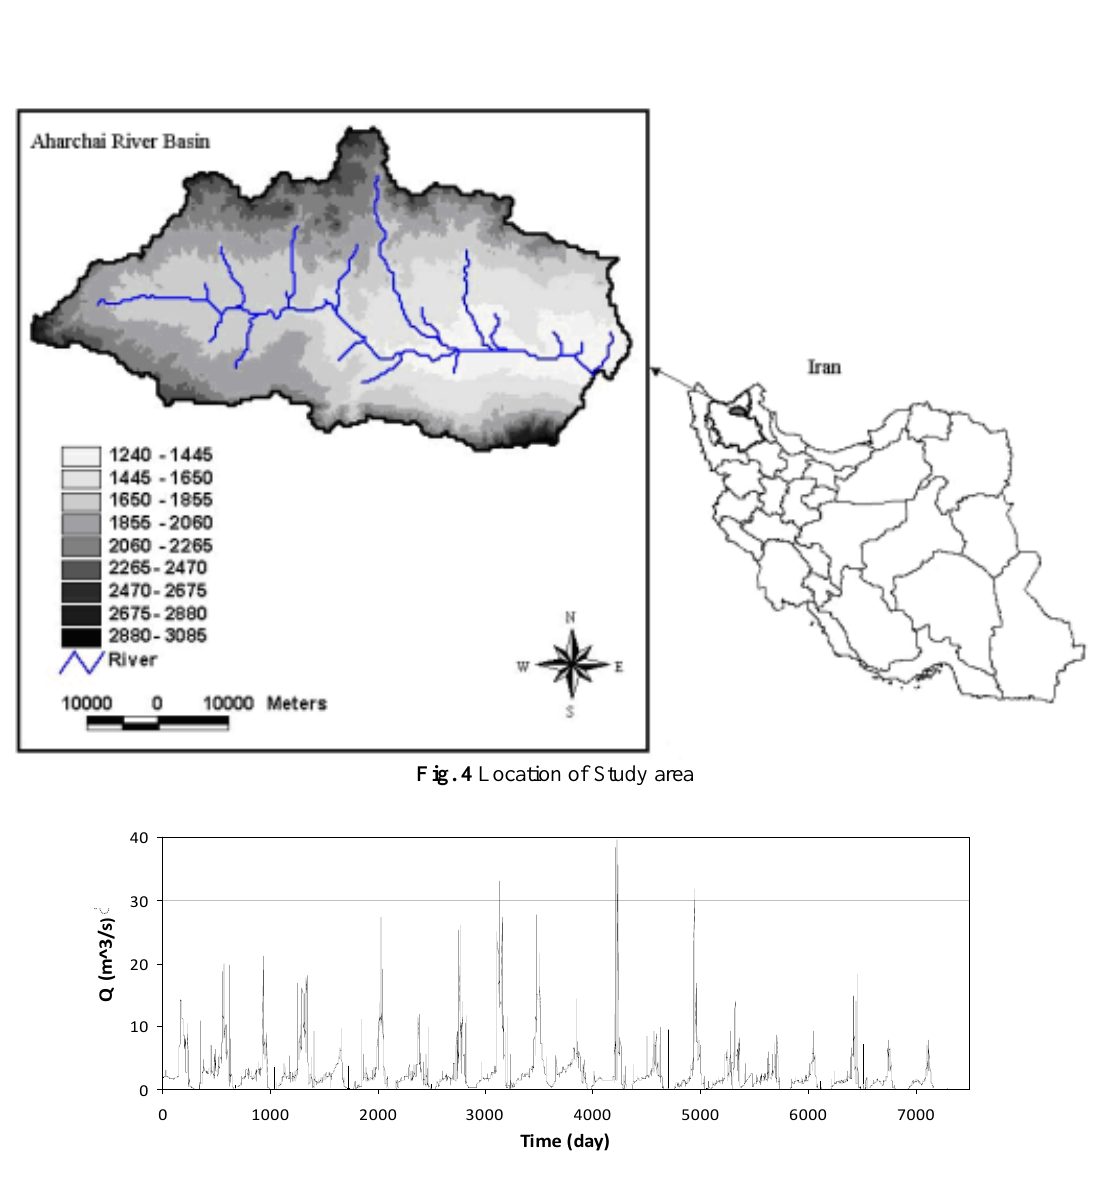
Fig. 5 Time series plot for river flow at Orang station in Aharchai river